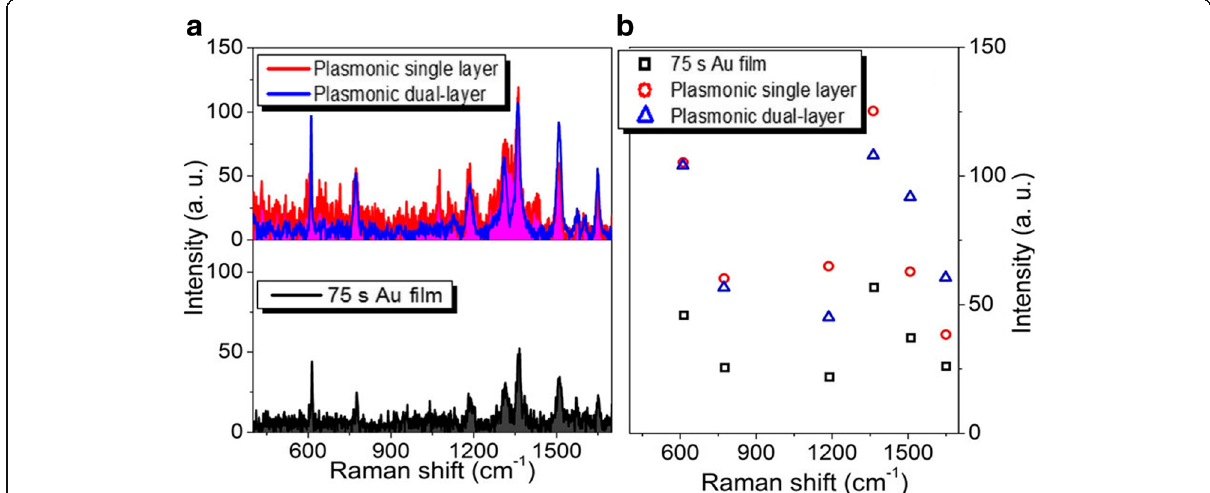
Fig. 8 a Raman spectra of the single-layer and dual-layer porous Au film structures and ultrathin Au film. b Intensity changes of several typical Raman peaks observed in the three Raman curves in a . The sputtering time for each layer of porous Au films and film is 75